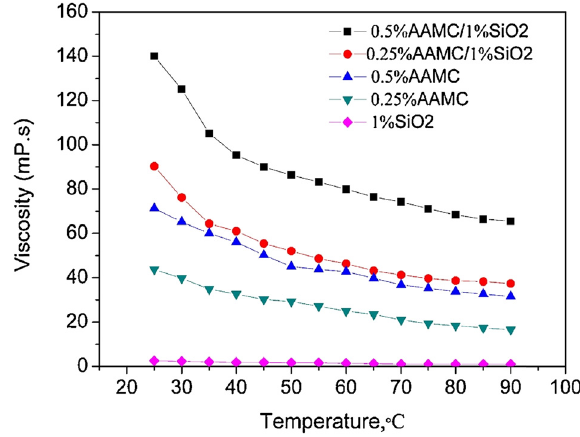
Figure 20: The e ff ects of temperature on viscosity of composite materials [ 124 ] ; Copyright: 2018 with permission from Elsevier Science